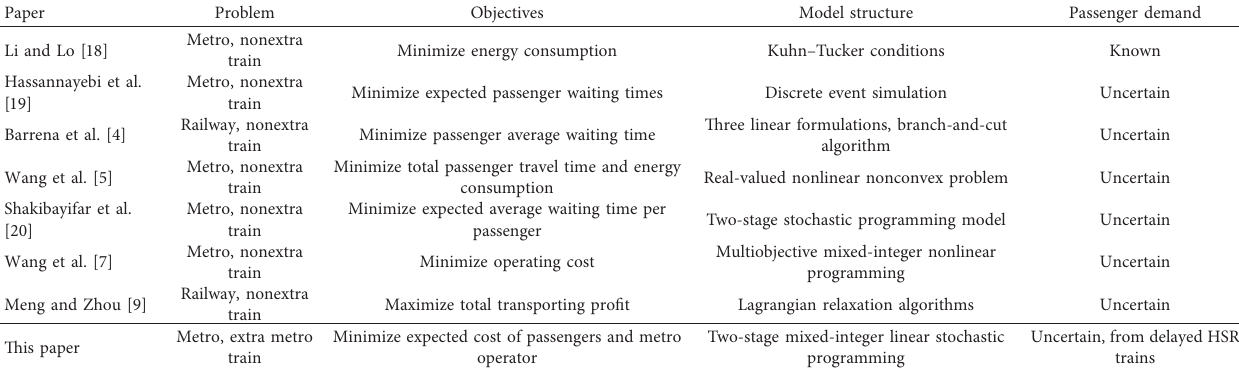
Table 2: Related papers with the studied problem, objective, model, and